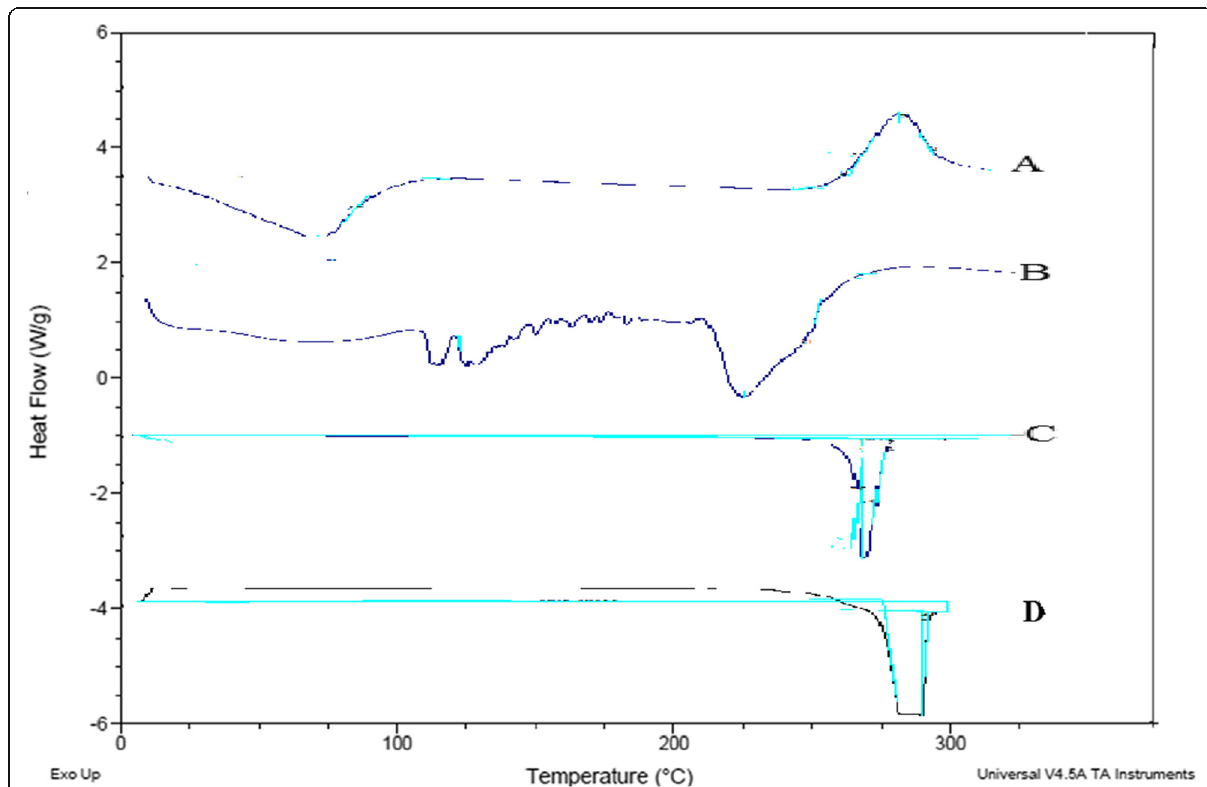
Fig. 8 DSC thermograms of ( A ) chitosan, ( B ) CMI, ( C ) mesalamine, and ( D ) chitosan-CMI nanoparticle